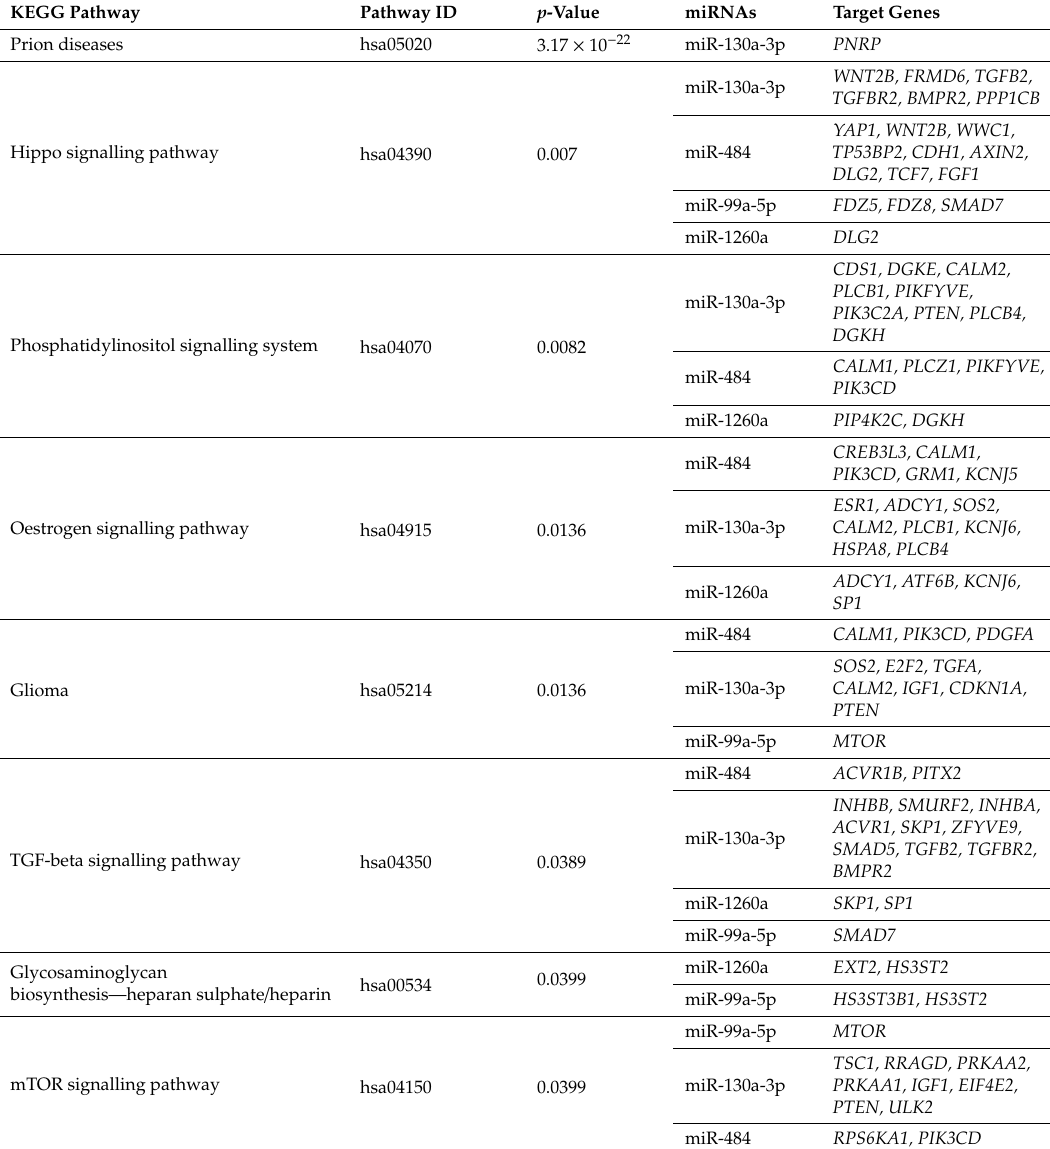
Table 3. Kyoto Encyclopaedia of Genes and Genomes (KEGG) analysis of the significantly up-regulated miRNAs in the plasma of BC